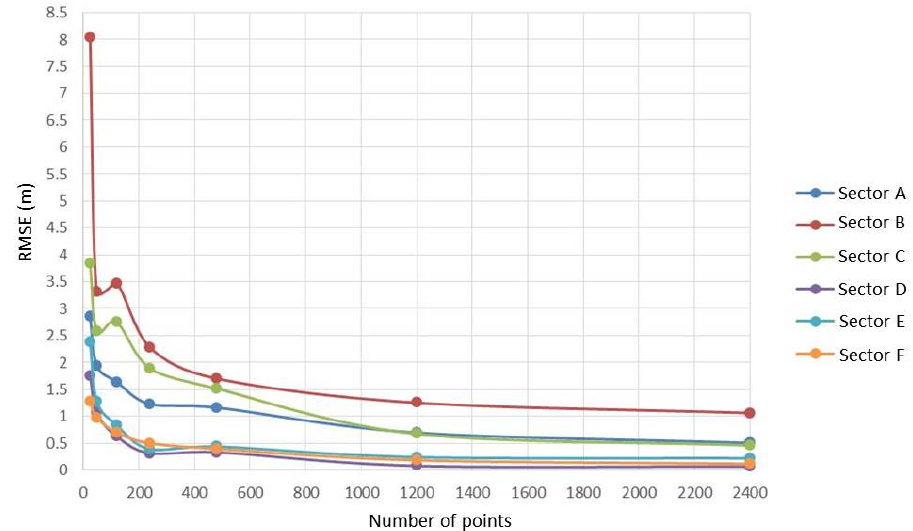
Figure 6. Direct comparison of Ordinary Kriging models with MBD: the variation of RMSE related to the number of points analyzed in each sector.